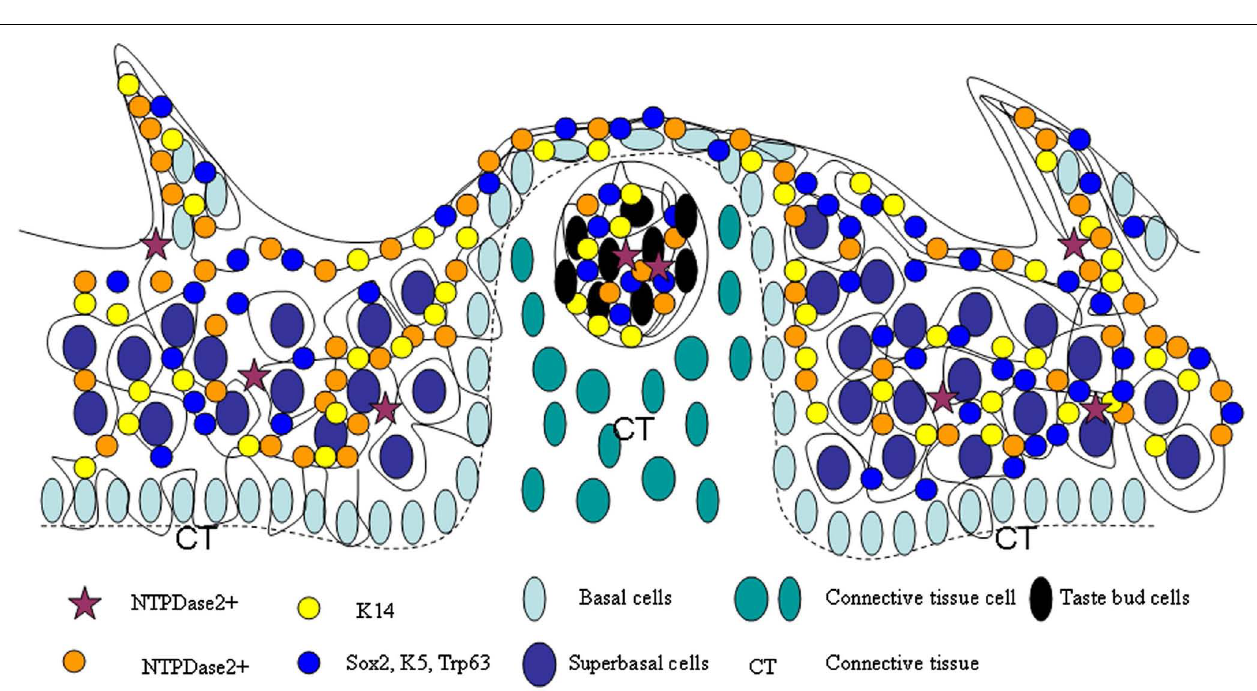
FIGURE 10 | Model of lingual epithelia cell genesis. Representation of a cell migration stream in lingual epithelia and lingual papillae, which is comprised of multiple stem cell populations, such as those expressing NTPDase2, K14, Sox2, K5, andTrp63.